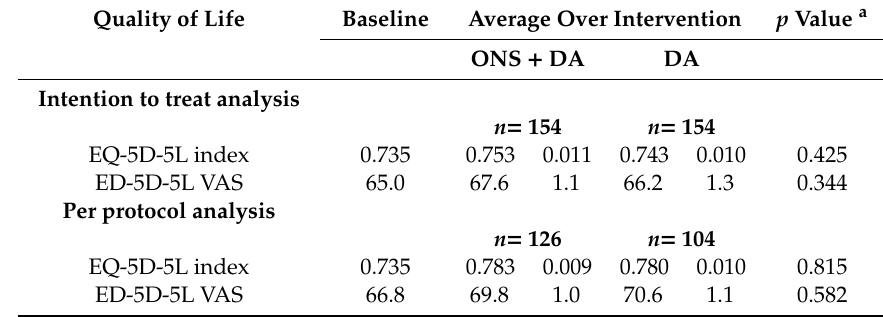
Table 3. Average quality of life (index and VAS) for the 12-week period according to type of intervention and analysis (intention to treat and per